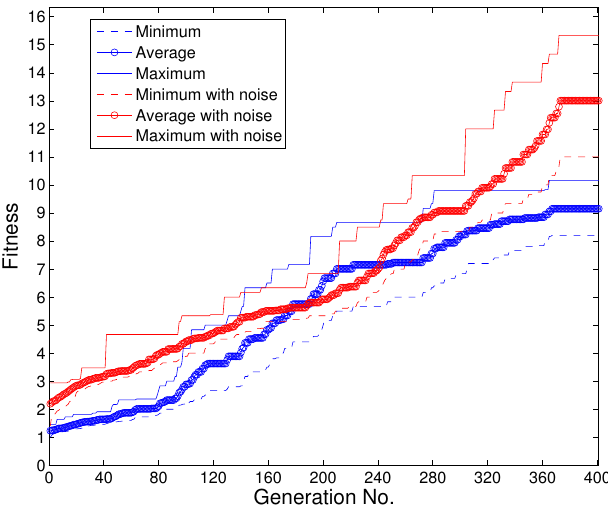
Figure 6. Transition of track fragmentation fitness f 1 (with vs. without